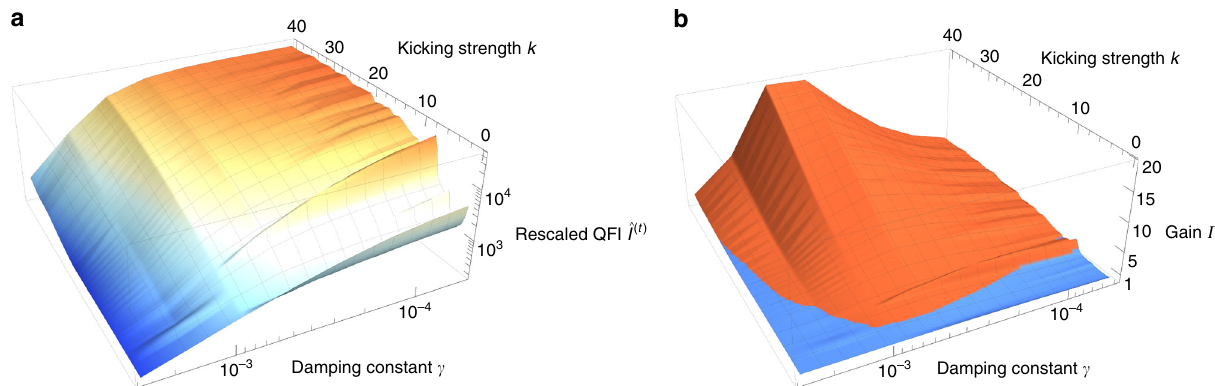
ð θ ¼ π = 2 ; ϕ ¼ π = 2 Þ DKT